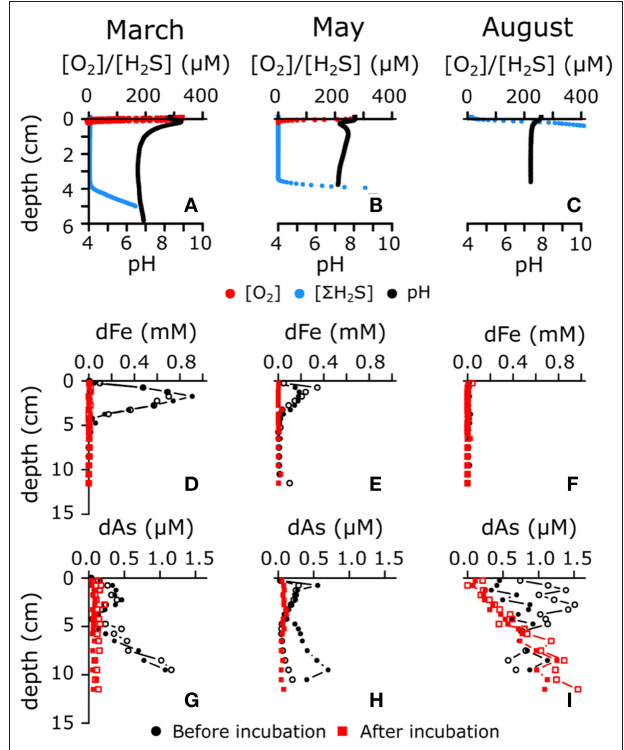
FIGURE 1 | (A–C) Representative microsensor depth profiles of O 2 , H 2 S, and pH in three different seasons (i.e., March, May, and August 2015) in sediment of seasonally hypoxic Lake Grevelingen. All microsensor profile replicates are shown in Supplementary Figure 2 . (D–F) Pore water depth profiles of dissolved iron in sediment upon core retrieval (denoted in black dots) and after prolonged incubation with anoxic overlying water (denoted in red squares). (G–I) Pore water profiles of dissolved arsenic before (denoted in black dots) and after (denoted in red squares) prolonged anoxic incubation. Open and filled symbols represent replicate